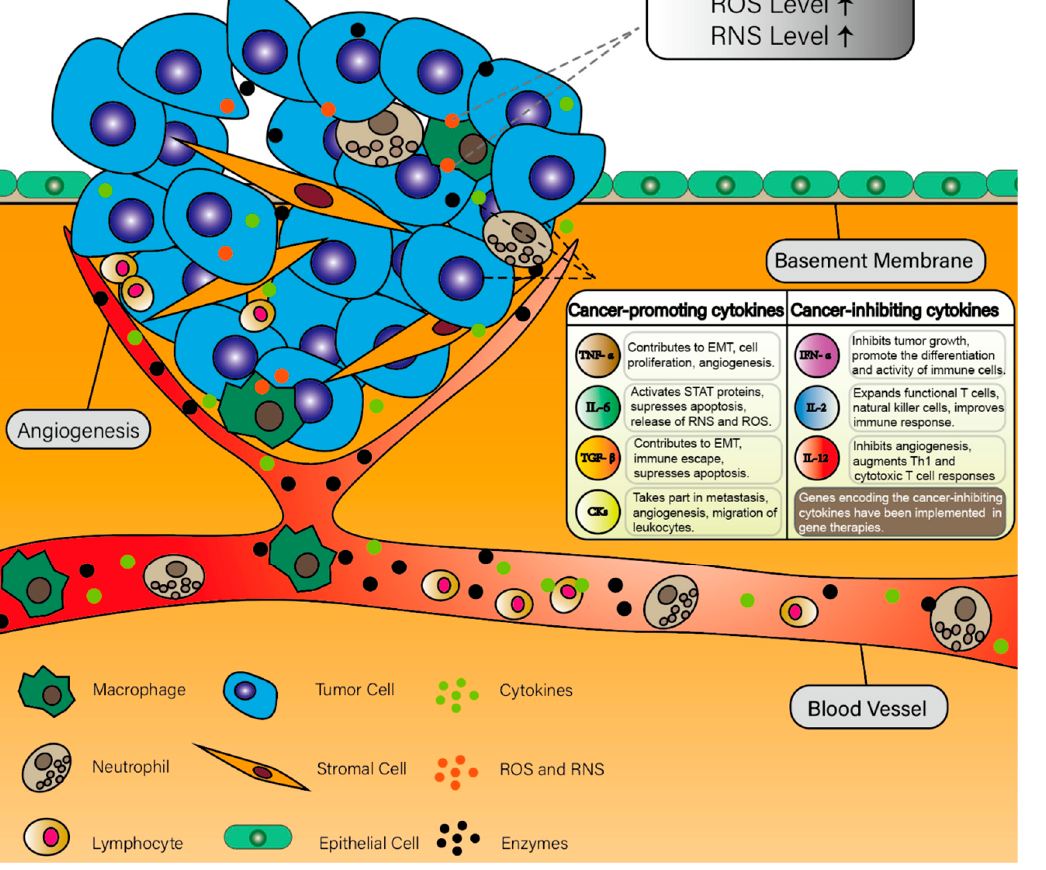
Figure 1. Critical inflammatory mediators in the tumor microenvironment.